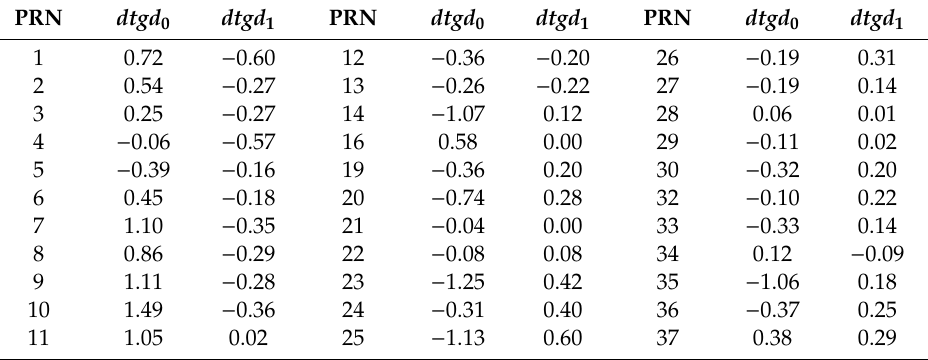
Table 6. Di ff erence of TGD bias from precise products and the network solution (in ns). dtgd 0 means the TGD bias at B3I frequency, and dtgd 1 is the residual TGD bias of TGD 1 . The average di ff erence for all satellites was